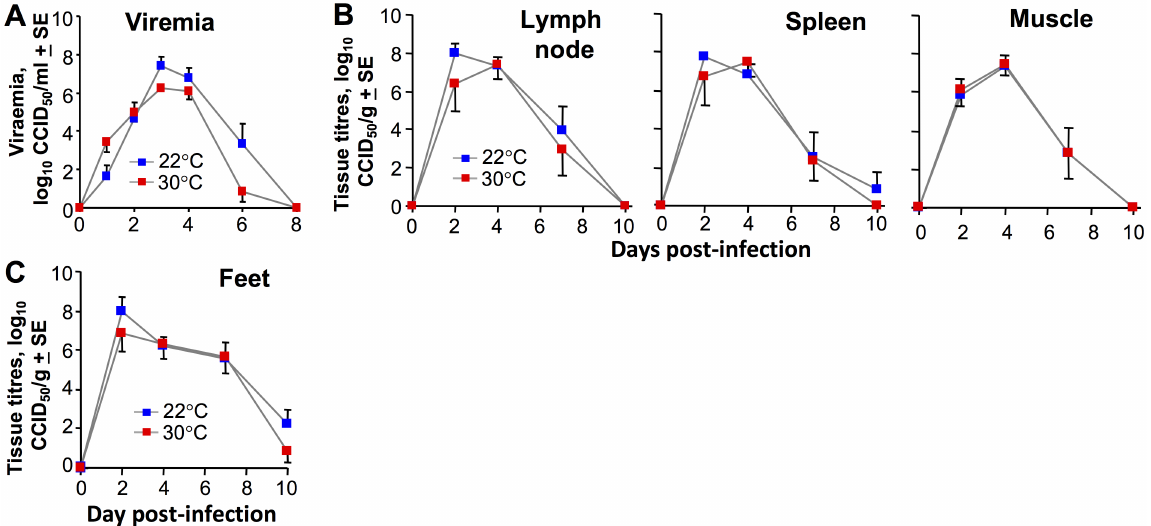
Fig 4. Intraperitoneal inoculation of CHIKV. Mice were housed at 22˚C or 30˚C and were infected i.p. with CHIKV. (A) Viremia (n = 6 per group). (B) Tissue titers (n = 6 per group, as in Fig 1). (C) Foot tissue titers (n = 6 mice, 12 feet per group).